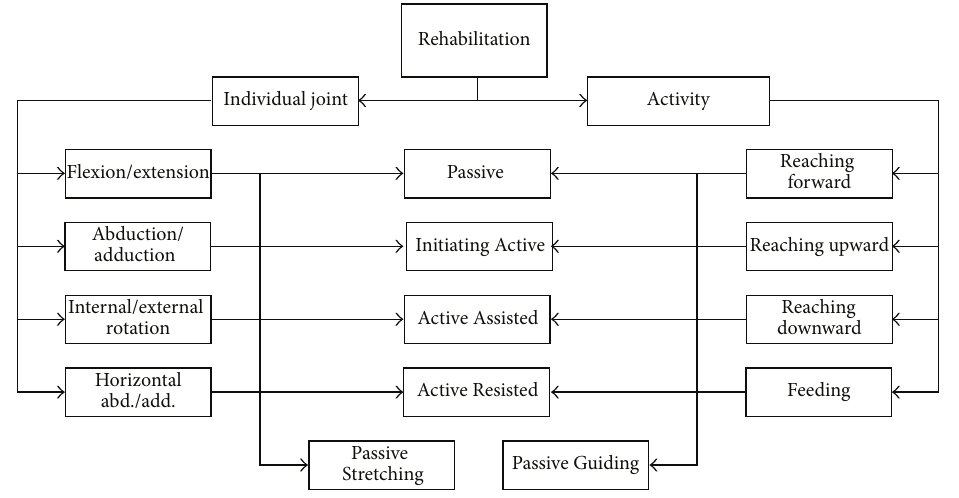
Figure 2: Rehabilitation